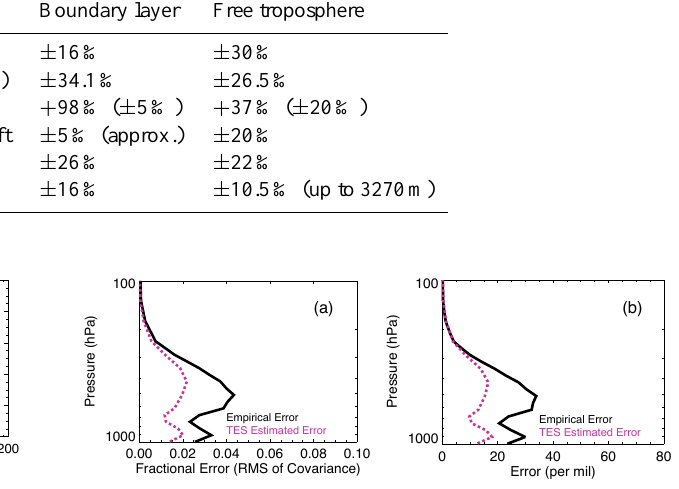
Figure 6 is a comparison for a single match (28 July 2012) between TES HDO / H 2 O estimated error (red dashed line) and the empirical error (solid black line). The error terms are